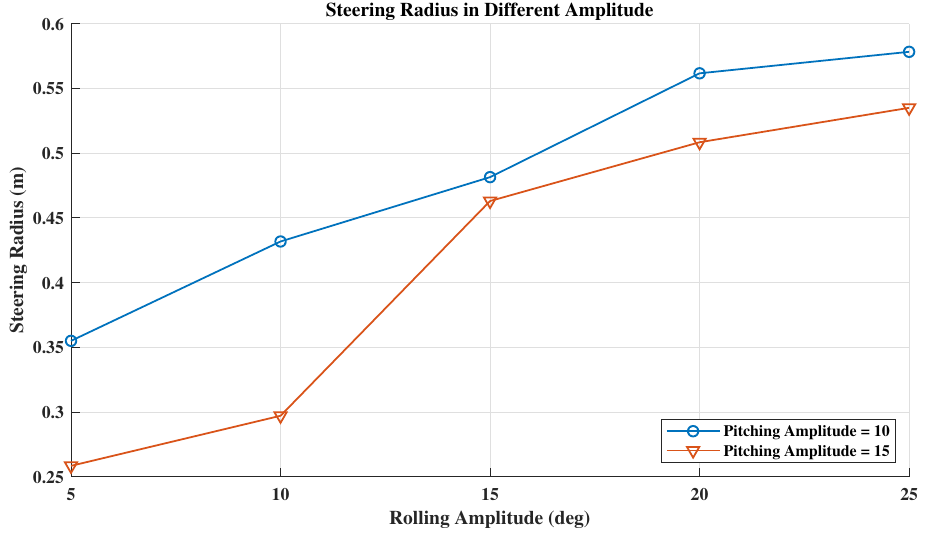
Figure 20. Steering radius in different